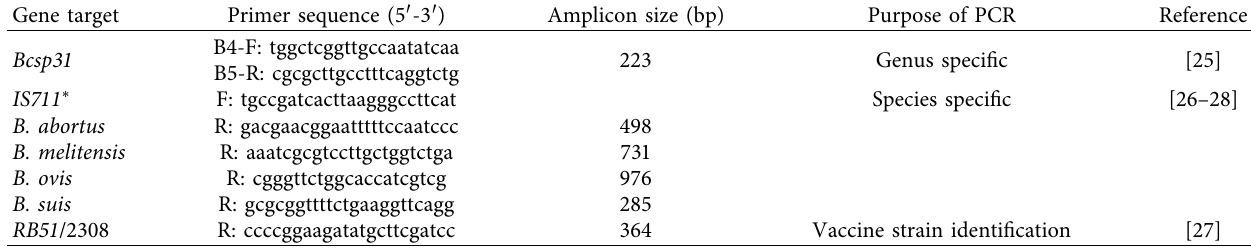
Table 1: Details of oligonucleotide primers used in this study.